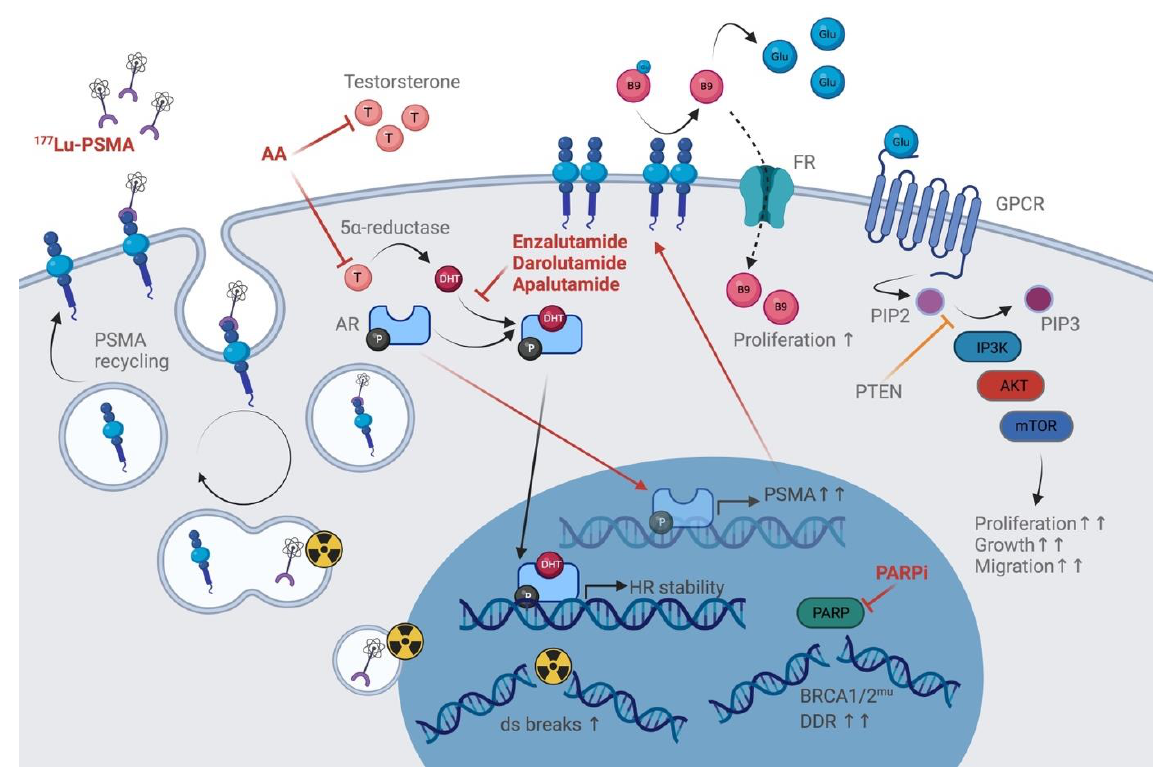
Figure 1. Multiple molecular interactions in prostate cancer cells. PSMA is internalized upon ligand binding, in this case the radiolabeled small molecule 177 Lu-PSMA-617. The ligand is transported to the perinuclear region for degradation and releases its β -radiation to induce ds breaks. The PSMA molecule is recycled and released to the cell surface. Testosterone binds to the AR in the cytoplasm. The AR–testosterone complex binds to binding motifs on the DNA and ensures HR. If suppressed by AA or enzalutamide, unbound AR binds to the PSMA enhancer and promotor region and upregulates PSMA expression. PSMA has enzymatic properties and releases free glutamate from polyglutamated folate (B9). B9 is transported into the cell via the FR and aids with proliferation. Free glutamates activate GPCRs, which downstream activate IP3K if not inhibited by PTEN. Via IP3K-mediated conversion of PIP2 to PIP3, activated IP3K–AKT–mTOR signaling promotes proliferation and tumor cell growth. In BRCA1/2-mutated cells, PARP is upregulated and strongly induces DDR. PARPi counteracts PARP-mediated DDR. Black arrows and grey letters indicate normal function; red arrows and letters indicate drug-mediated functions. 177LU: 177Lutetium; PSMA: prostate-specific membrane antigen; AA: abiraterone actetate; DHT: dihydroxy-testosterone; T: testosterone; HR: homologous recombination; ds: double-strand; Glu: glutamate; FR: folate receptor; GPCR: G-protein-coupled receptor; PIP2: phosphatidylinositol-4, 5-bisphosphate; PIP3: phosphatidylinositol-3, 4, 5-triphosphate; IP3K: inositol 1,4,5-trisphosphate 3-kinase; AKT: protein kinase B; mTOR: mammalian target of rapamycin; PTEN: phosphatase and tensin homolog on chromosome ten; PARP: poly(ADP-ribose)-polymerase; PARPi: PARP inhibitor; BRCA1/2mu: breast cancer 1/2 mutation; HR: homologous recombination; DDR: DNA-damage repair. This figure was generated using biorender, www.biorender.com, accessed on 8 July